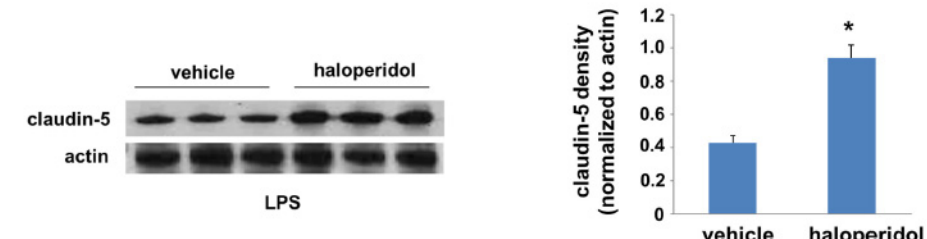
Figure 4. Lung claudin-5 expression is increased by haloperidol in vivo. A murine model of ALI was utilized to study the effects of haloperidol in vivo. Lungs were harvested from LPS-treated animals that had been pretreated with haloperidol (4 mg/kg, IP) or vehicle for 24 h and whole lung homogenates were used for Western blotting of claudin-5 (representative blots shown; n = 3/group, * p < 0.05 compared to controls).